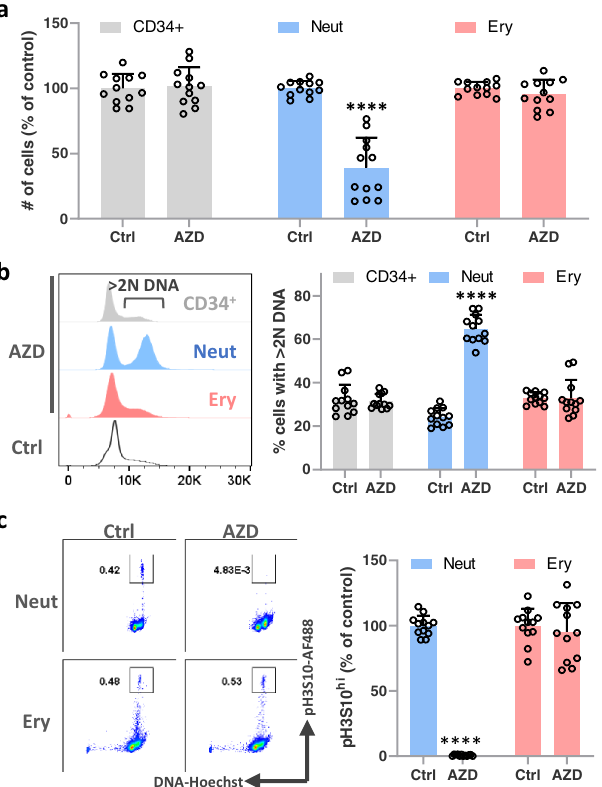
Fig. 1 | AZD2811 causes neutrophil-speci fi c toxicity in vitro. Human CD34 + pro- genitorcellswereculturedfor10daysandthentreatedfor48hwithAZD2811atthe clinically relevant concentration of 42nM or left untreated. a Cells were harvested and analyzed by fl ow cytometry to measure cell numbers. b DNA content was measured via Hoechst 33342 staining. Representative fl ow histograms are shown for CD34 + progenitor, neutrophil lineage, and erythroid cells in the presence of AZD2811 as well as bulk untreated cells. Bar graphs display quantitation of the percentage of cells with >2N DNA content. c Phosphorylation of histone H3 at serine 10 (pH3S10) was measured by intracellular staining and the % of cells with bright pH3S10 staining was quanti fi ed relative to controls without AZD2811. Representative fl ow cytometry plots are shown alongside quantitative bar graphs. Mean and SD are shown; n =12, from 4 independent experiments. **** p <0.0001, two-sided t test. Source data are provided in the Source Data fi le.